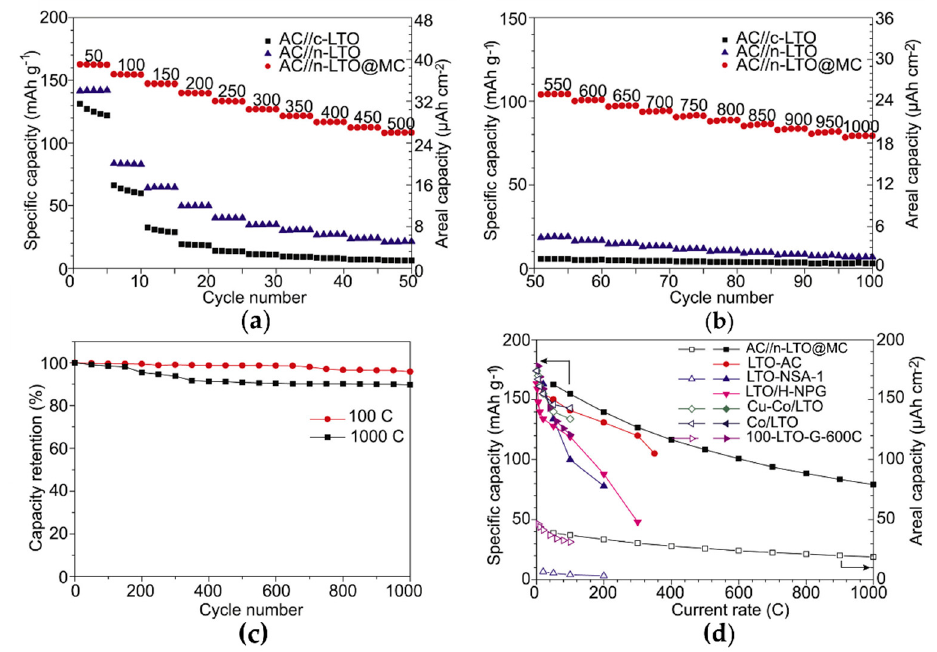
Figure 2. ( a , b ) Rate performances of AC//c-LTO, AC//n-LTO, and AC//n-LTO@MC asymmetric capacitors. Charge/dis- charge tests of the Li-ion capacitors (LICs) at current rates ranging from 50 to 1000 C. The valued are calculated based on the theoretical capacity of LTO and the active mass in the electrodes. More info reported in section 2.3 of [34] ; ( c ) Capacity retention of AC//n-LTO@MC over 1000 cycles at 100 and 1000 C; ( d ) Performance comparison of AC//n-LTO@MC and recently reported LTO-based high-rate LICs including LTO encapsulated in activated carbon(LTO-AC) [35] , self-sup- ported LTO nanosheet arrays (LTO-NSA) [36] , LTO wrapped in nanoperforated graphene (LTO/H-NPG) [37] , LTO sup- ported on pine-needle-like Cu–Co skeletons (Cu–Co/LTO) [38] , LTO combined with metallic Co cores (Co/LTO) [39] , and LTO deposited on graphene (LTO-G) [40] (filled symbols: specific capacities; hollow symbols: areal capacities). Adapted from [34]